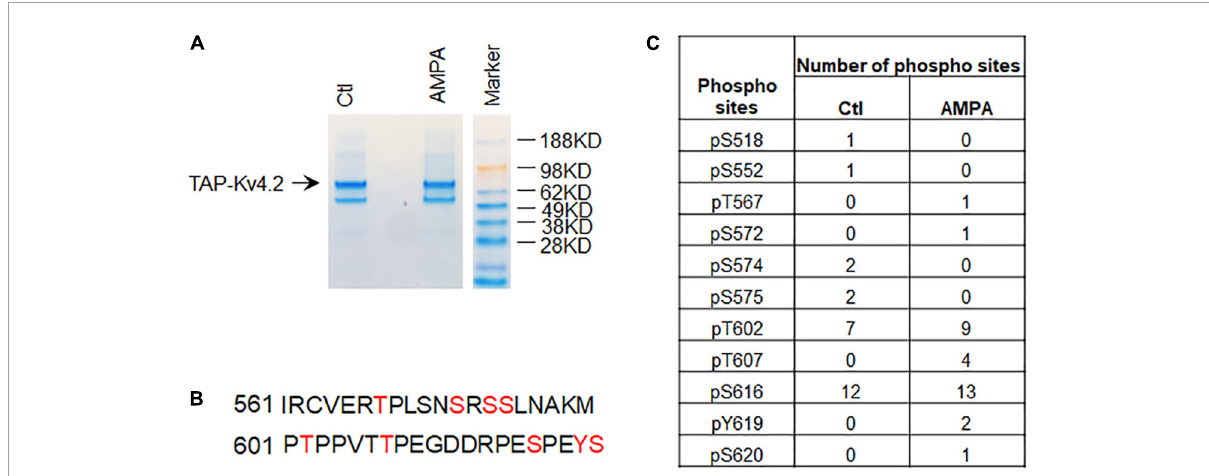
FIGURE4 Identification of Kv4.2 phosphorylation sites in hippocampal neurons by TAP. (A) Coomassie staining showing TAP-Kv4.2 is purified by TAP using stronger lysis buffer (1% Triton X-100 and 0.5% DOC) in the control and AMPA treatment conditions. (B) Phospho-peptides of Kv4.2 that contain multiple phosphorylation sites identified by TAP-MS. (C) Number of phospho-sites in Kv4.2 were identified by TAP-MS in control and AMPA (50 µ M for 15 min) treatment in culture hippocampal neurons. Note that T607 phospho-peptides but not T602 and S616 phospho-peptides were increased in AMPA treatment compared to